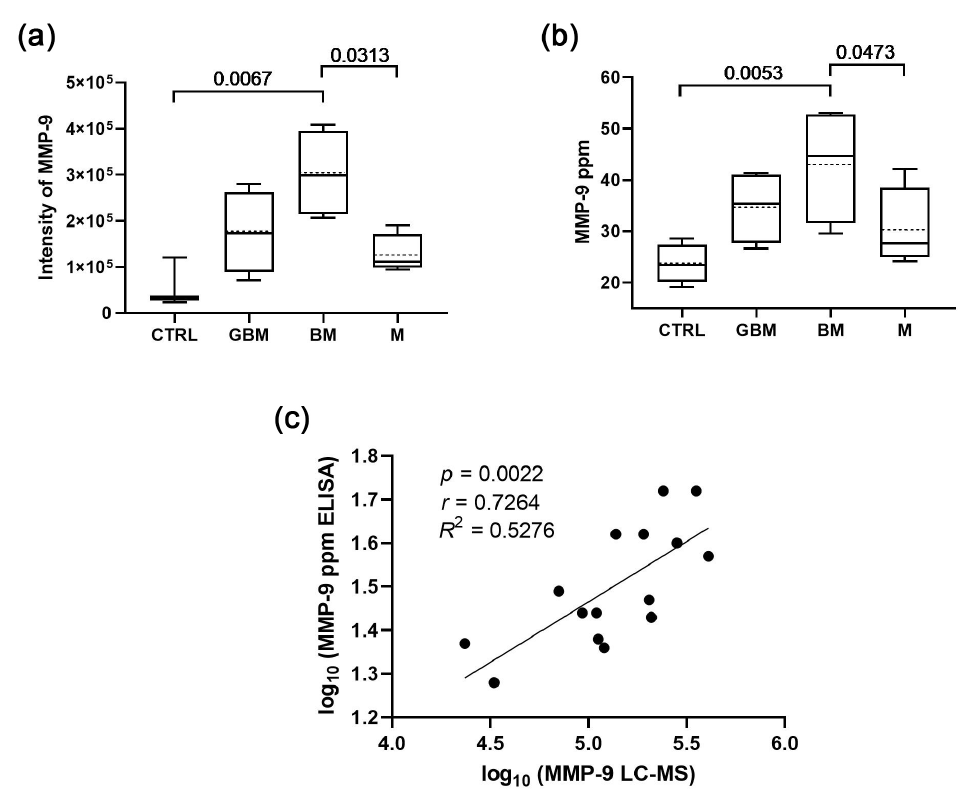
Figure 1. Comparison of the sEV MMP-9 content measured by ELISA with the LC-MS results. ( a ) MMP-9 levels of serum-derived sEVs based on LC-MS data (boxplot shows median with in- terquartile range, mean with dotted line, error bars range from the 5th–95th percentiles (nCTRL = 3, nGBM = 4, nBM = 4, nM = 4). ( b ) MMP-9 levels of serum-derived sEVs based on ELISA data (nCTRL = 4, nGBM = 4, nBM = 4, nM = 4). Dotted lines indicate mean values. ( c ) Correlation between the MMP-9 levels measured by LC-MS and ELISA.